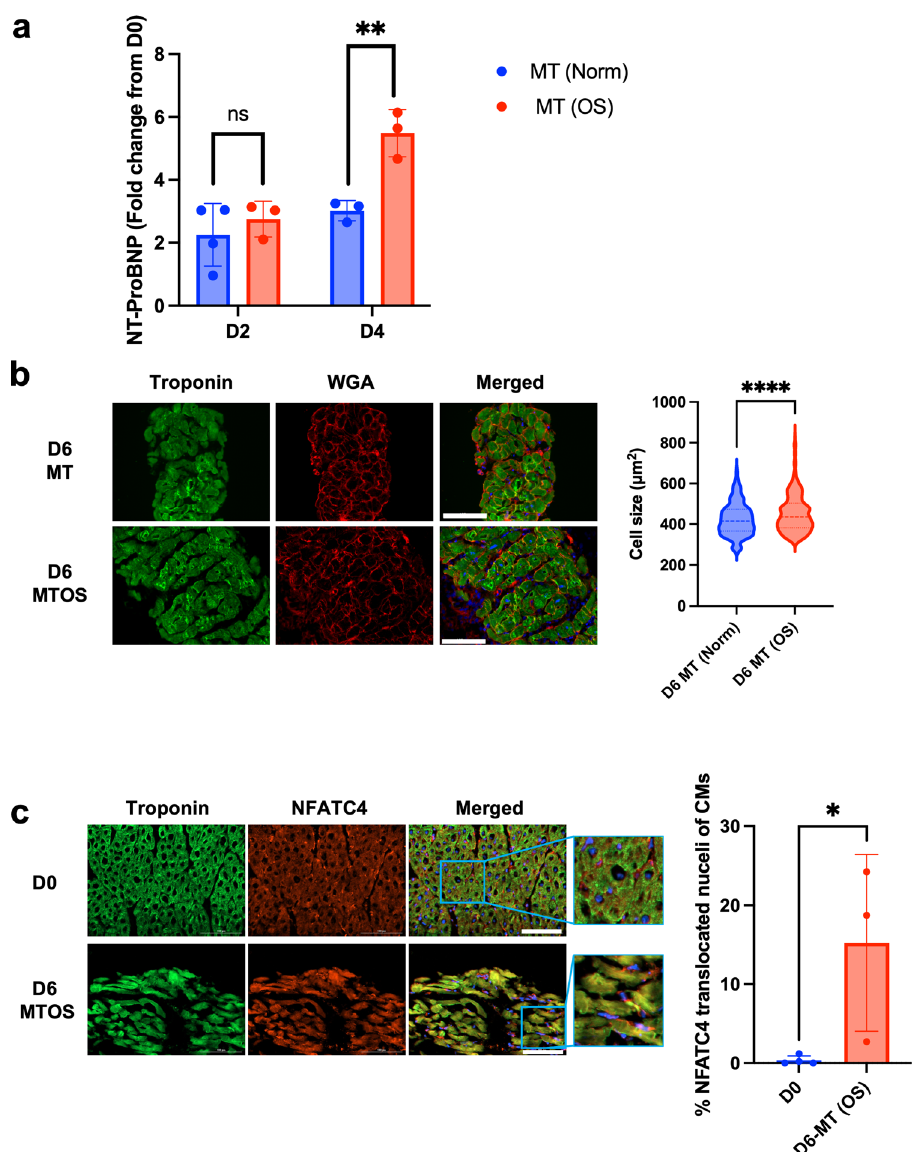
Fig. 7 Overstretching in CTCM induces pathological hypertrophy. a Bar graph quanti fi cation of NT-ProBNP concentration in culture media from heart slices cultured under MT normal stretch (Norm) or overstretching (OS) conditions ( n = 4 (D2 MTNorm), 3 (D2 MTOS, D4 MTNorm, and D4 MTOS) slices/group from different pigs, Two-way ANOVA is performed; ** p < 0.01 compared to normal stretch). b Representative images for heart slices stained with troponin-T and WGA (left) and cell size quanti fi cation (right) ( n = 330 (D6 MTOS), 369 (D6 MTNorm) cells/group from 10 different slices from different pigs, Two-tailed Student t -test is performed; **** p < 0.0001 compared to normal stretch). c Representative images for day 0 and day 6 MTOS heart slices immunolabeled for troponin-T and NFATC4 and quanti fi cation of the translocation of NFATC4 to the nuclei of CMs ( n = 4 (D0), 3 (D6 MTOS) slices/group from different pigs, Two-tailed Student t-test is performed; * p < 0.05). Error bars are representative of the Mean±